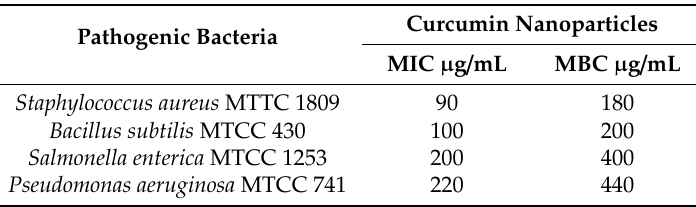
Table 2. The MIC (Minimum Inhibitory Concentration) and MBC (Minimum Bactericidal Concentration) of the curcumin nanoparticles.